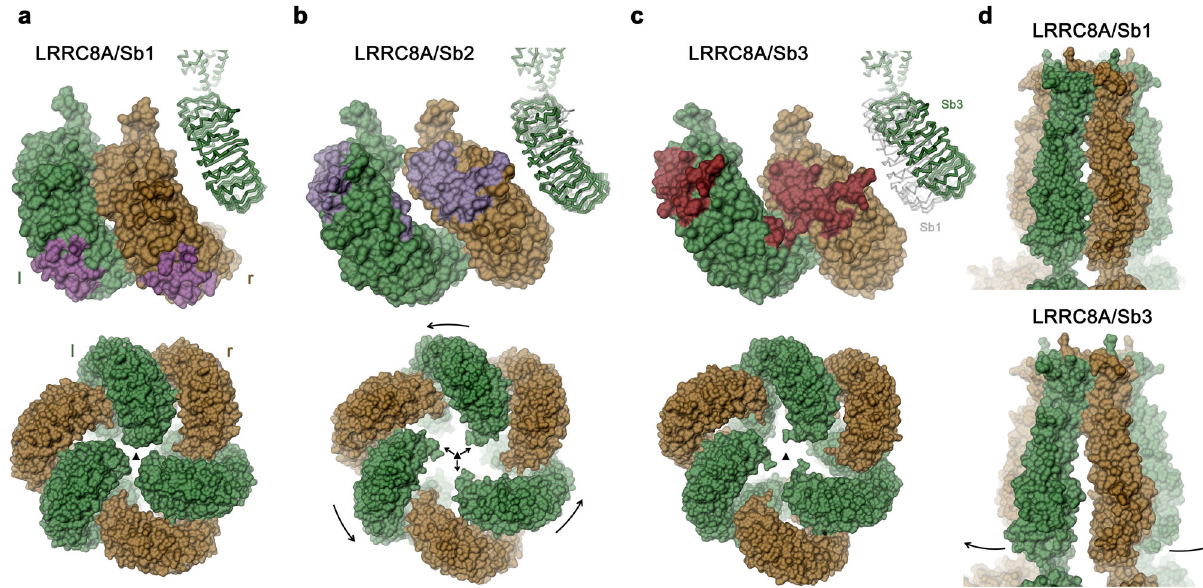
Fig. 6 Conformational changes of LRRC8A in response to inhibitory sybody binding. a LRRC8A/Sb1 complex, b LRRC8A/Sb2 complex, c LRRC8A/Sb3 complex. a – c Shown are surface representations of domain pairs at the tight interface (top) with contact regions with bound sybodies colored and the hexameric assembly of the domains viewed from the cytoplasm with symmetry axis indicated as triangle (bottom). Insets (top right) display C α trace of the right subunit of the respective structure, which is superimposed in b and c on the respective structure of the complex with sybody Sb1. d Surface representation of the pore domain of the LRRC8A/Sb1 (top) and the LRRC8A/Sb3 complex (bottom) viewed from within the